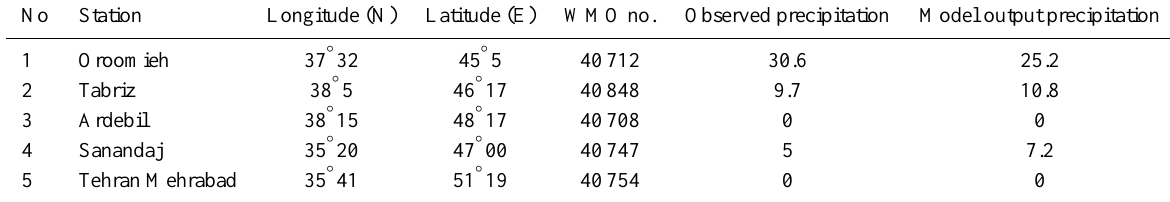
Table 2. Accumulate precipitation on 14 March 2009 for observation and model output.